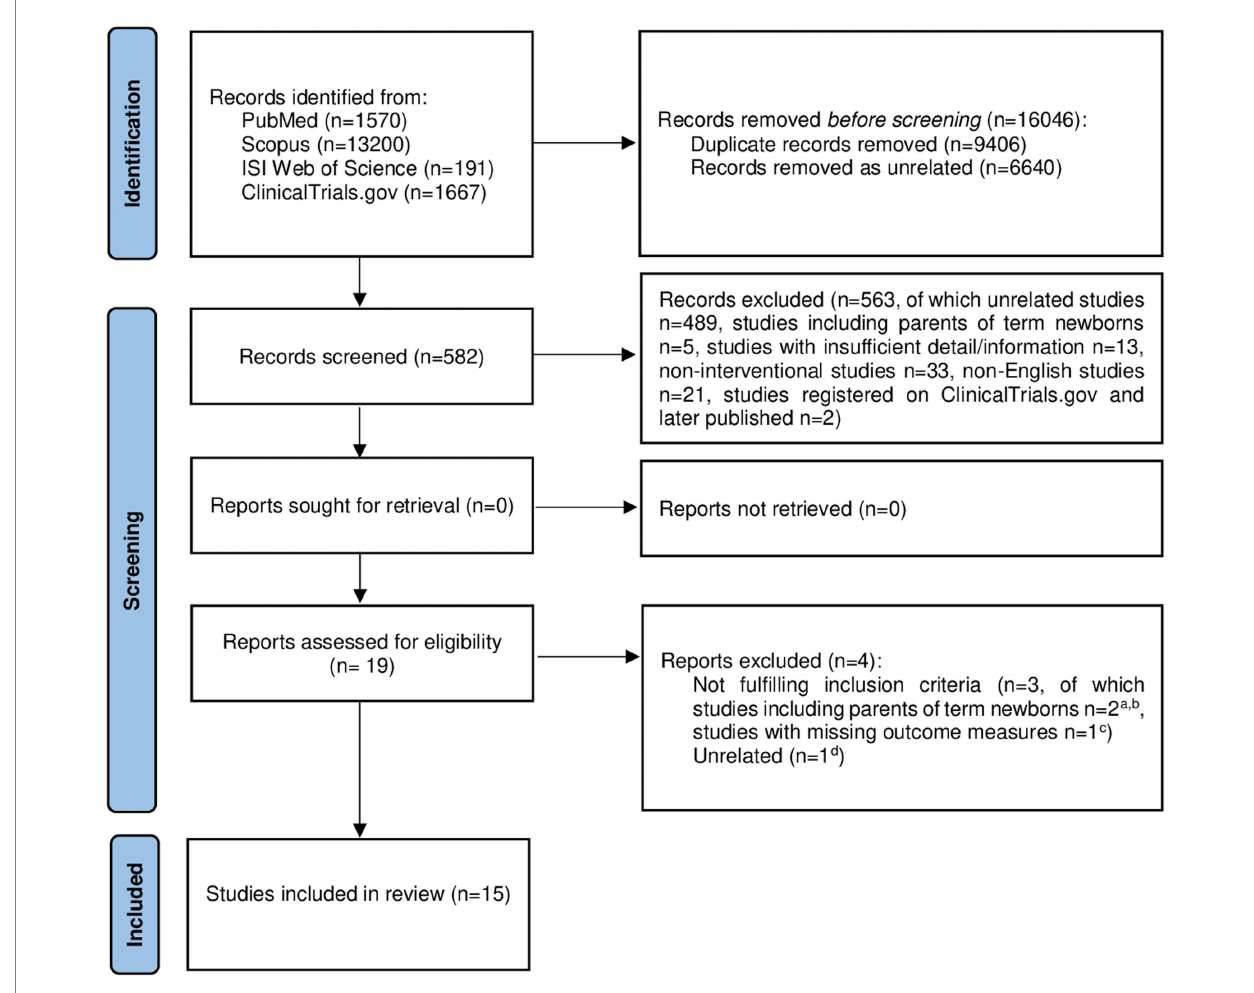
FIGURE 1 PRISMA 2020 flow diagram showing the selection process of the intervention studies included in our systematic review (28). a Barry et al. (29); b Oyekunle et al. (30); c Jotzo and Poets (31); d Holditch-Davis et al. (32). Adapted with permission from Page et al. (28), licensed under CC-BY